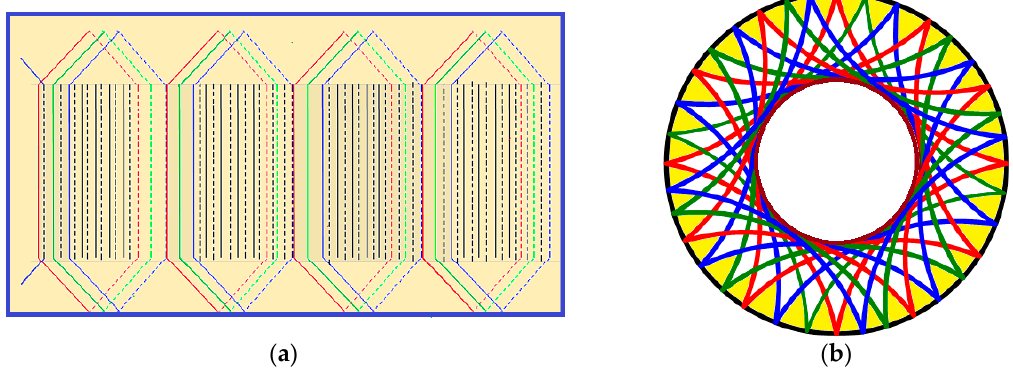
Figure 4. ( a ) Arrangement of the three-phase windings of the motor in slots. ( b ) Placement of the three-phase windings on the stator.